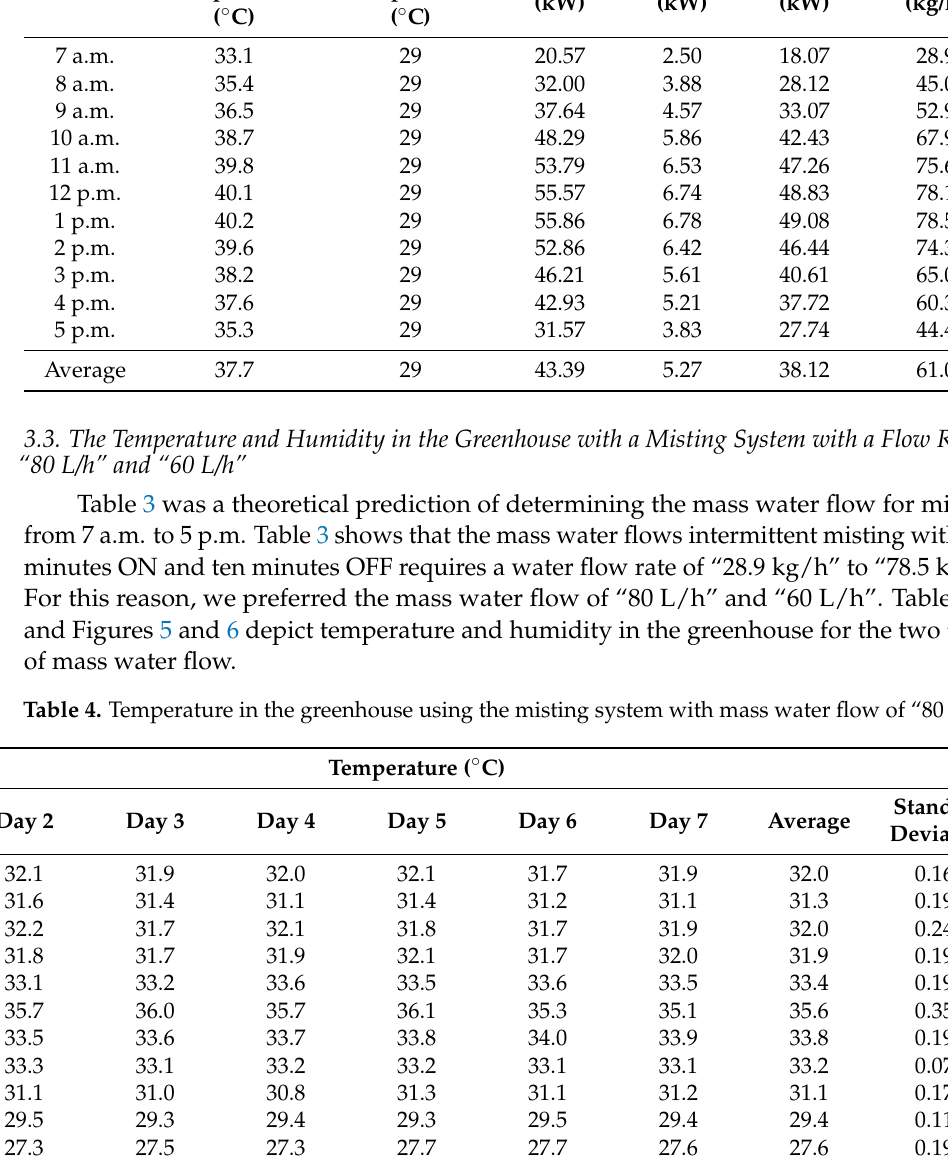
Table 3. Mass water flow for misting based on heat/energy balance.